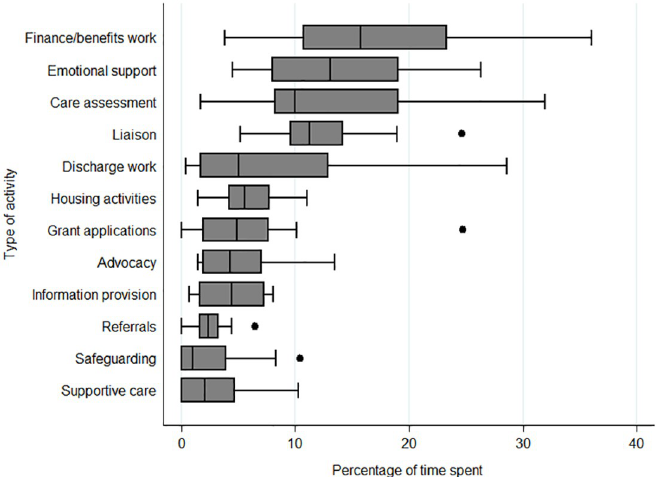
Fig 2. Main RSW activities, based on time spent per